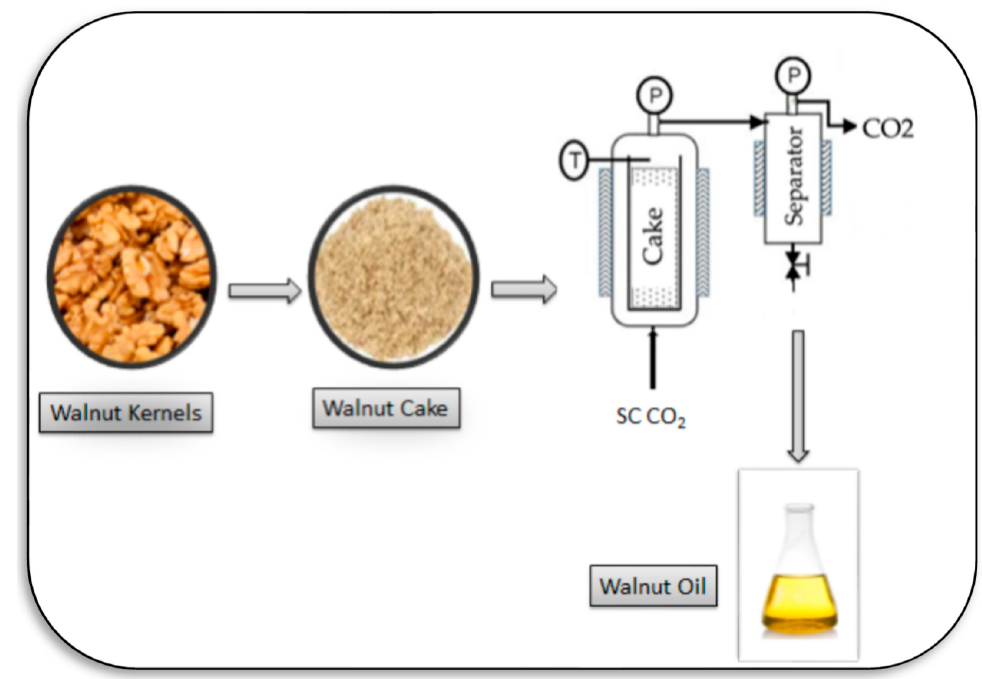
Figure 3. Supercritical fluid extraction method .